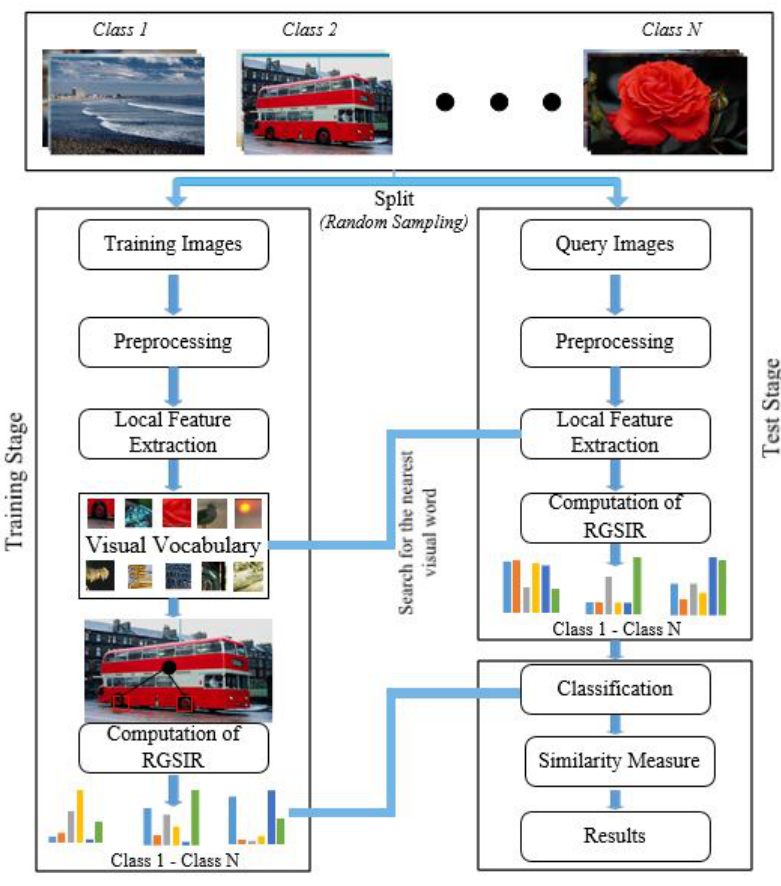
Figure 3. Block diagram of the proposed